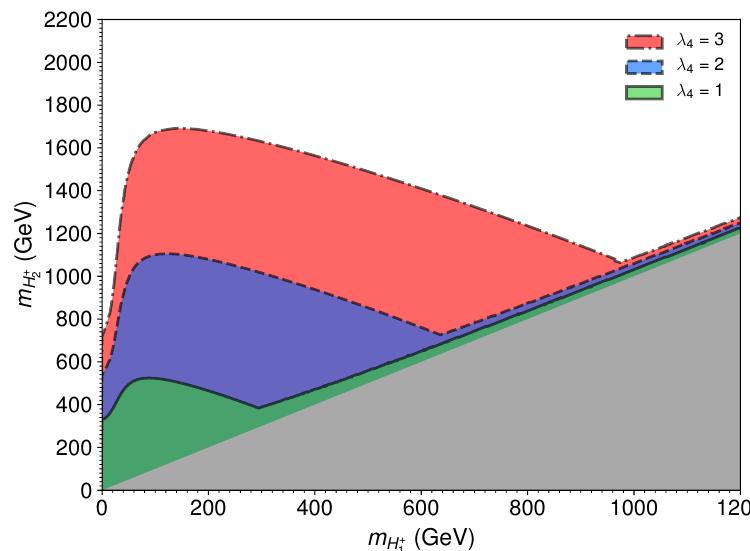
Figure 9 . Excluded region (in colour) in the ( m from the combination of bounds on electroweak precision observables ((cid:1) T eq.